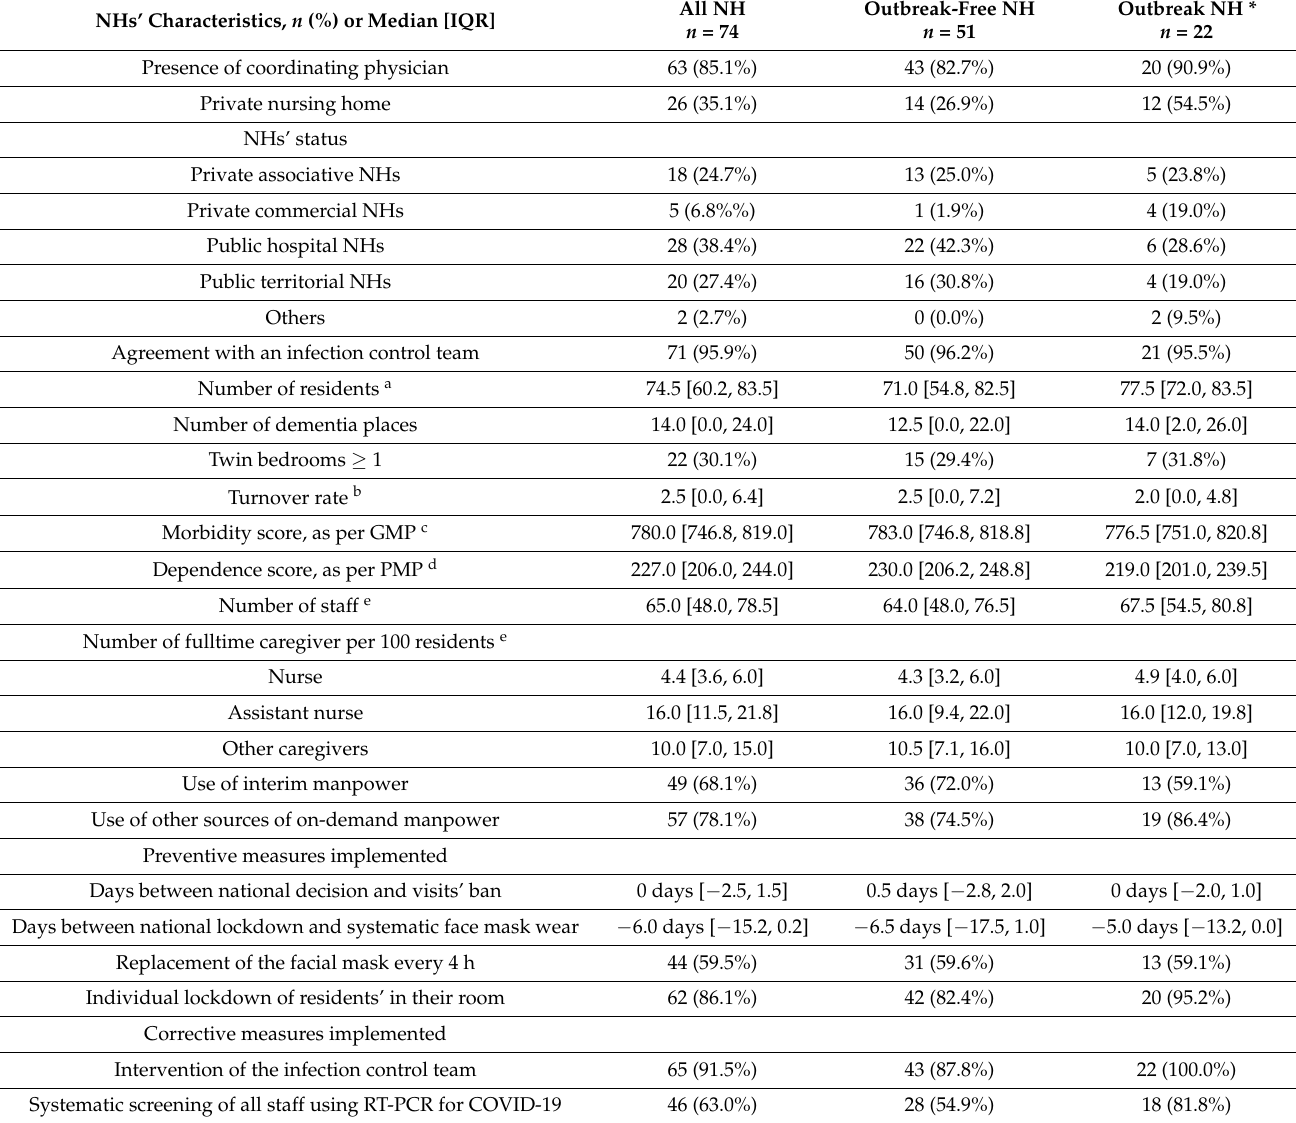
Table 1. Characteristics of nursing homes (NHs) and of the measures implemented to prevent and control the epidemic overall, in outbreak and in outbreak-free nursing